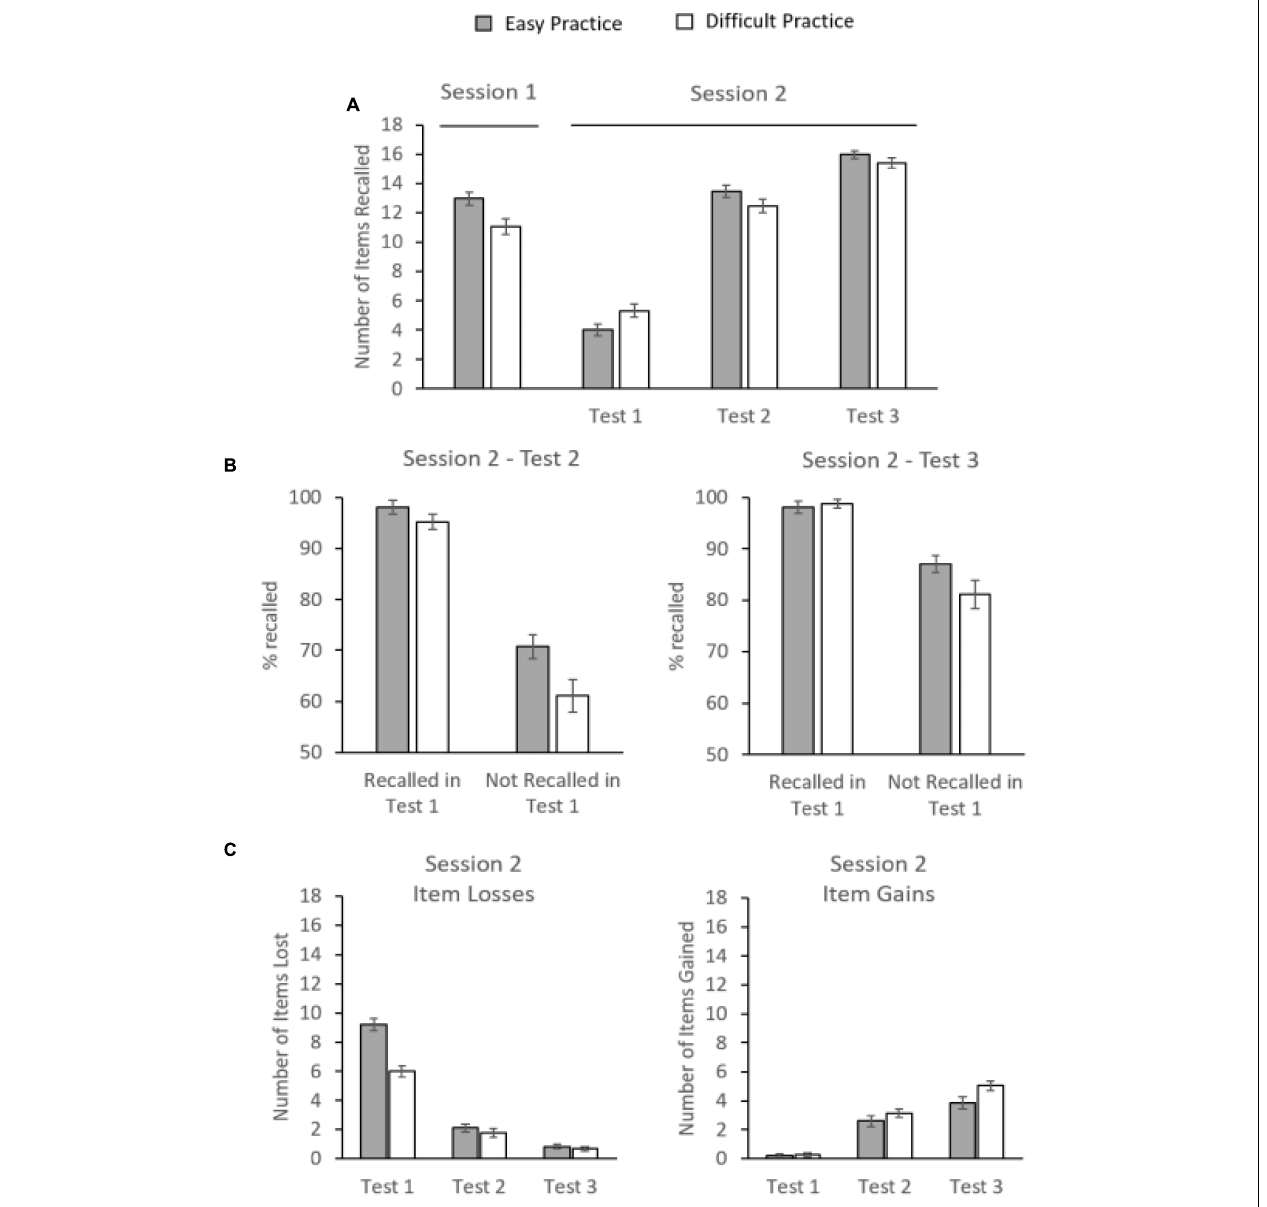
FIGURE 3 | (A) Session 1: Mean retrieval success during the initial retrieval-practice cycle in Session 1. Session 2: Percentage of correctly recalled study items in Session 2 as a function of PRACTICE TYPE (difficult practice, easy practice) and TEST (Test 1, Test 2, and Test 3). (B) Left panel: Conditional analyses of recall in Test 2 showed that the reversed retrieval-effort effect arose from a practice effect for items that were not recalled in Test 1. No such practice effect arose for items that were successfully recalled in Test 1. Right panel: Conditional analyses of recall in Test 3 showed that the reversed retrieval-effort effect arose from a practice effect for items that were not recalled in Test 1. No such practice effect arose for items that were successfully recalled in Test 1. (C) Left panel: Item losses on Tests 1, 2, and 3 relative to initial retrieval practice. Right panel: Item gains on Tests 1, 2, and 3 relative to initial retrieval practice. Error bars represent standard